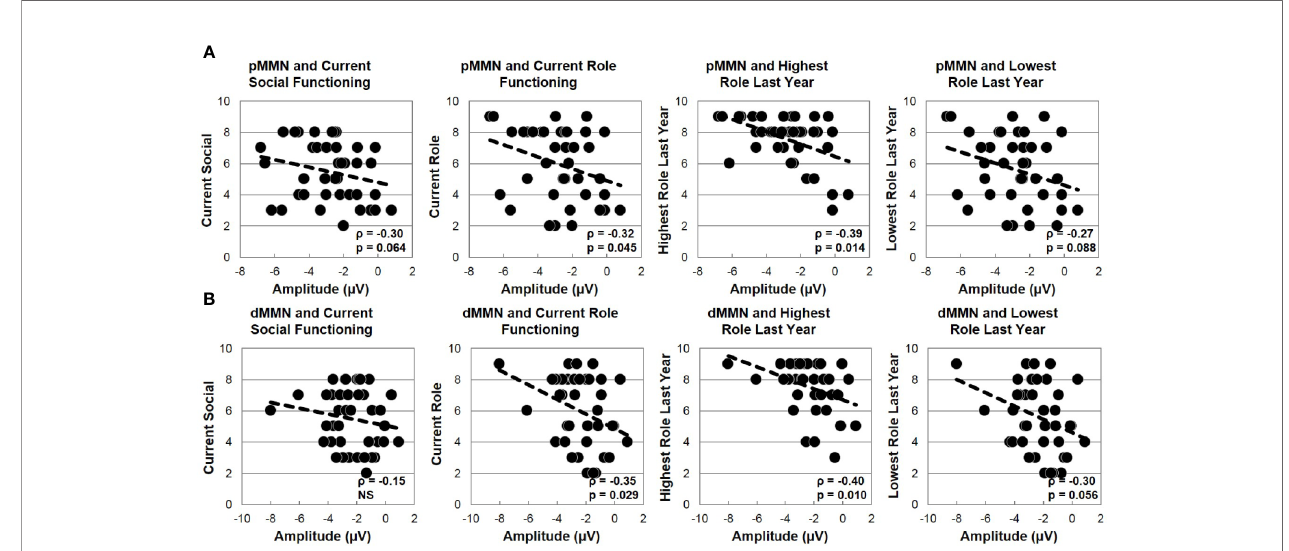
FIGURE 5 | MMN and social functioning in the fi rst episode schizophrenia spectrum. (A) Correlations with pMMN. (B) Correlations with